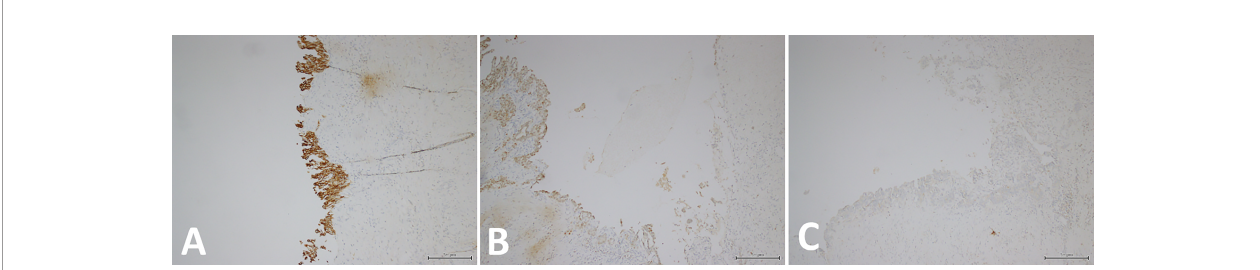
FIGURE 2 | (A) Immunohistochemistry revealed that the tumor cells of the right kidney tumor were CK7-positive. (B) Immunohistochemistry also revealed that the tumor cells of the right kidney tumor were PAX2-positive. (C) Immunohistochemistry showed that the tumor cells of right kidney tumor